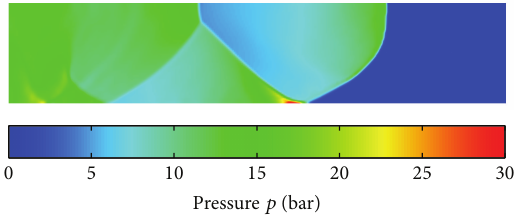
Figure 16: Pressure distribution in a steadily propagating detona- tion in a mixture with 25% H 2 (max. concentration